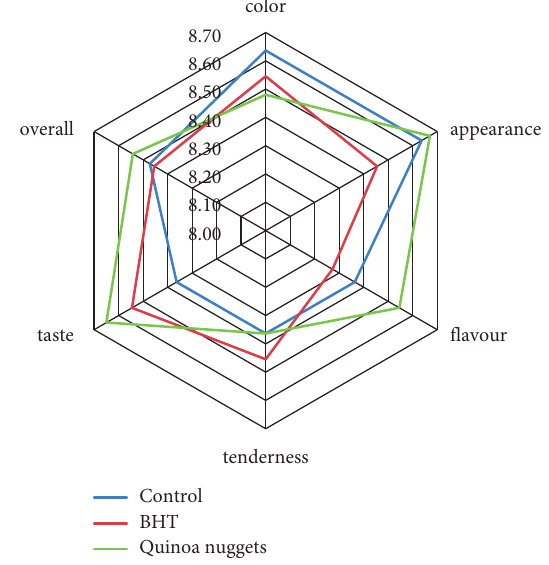
Figure 7: The sensory scores of chicken nuggets.